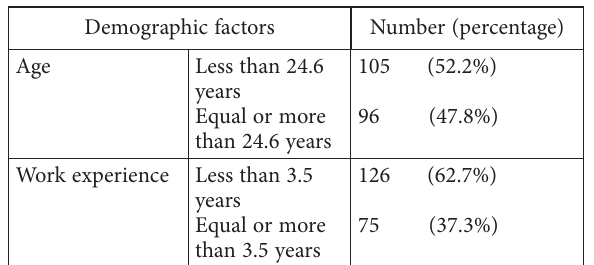
Table 1. Demographic data of the respondents